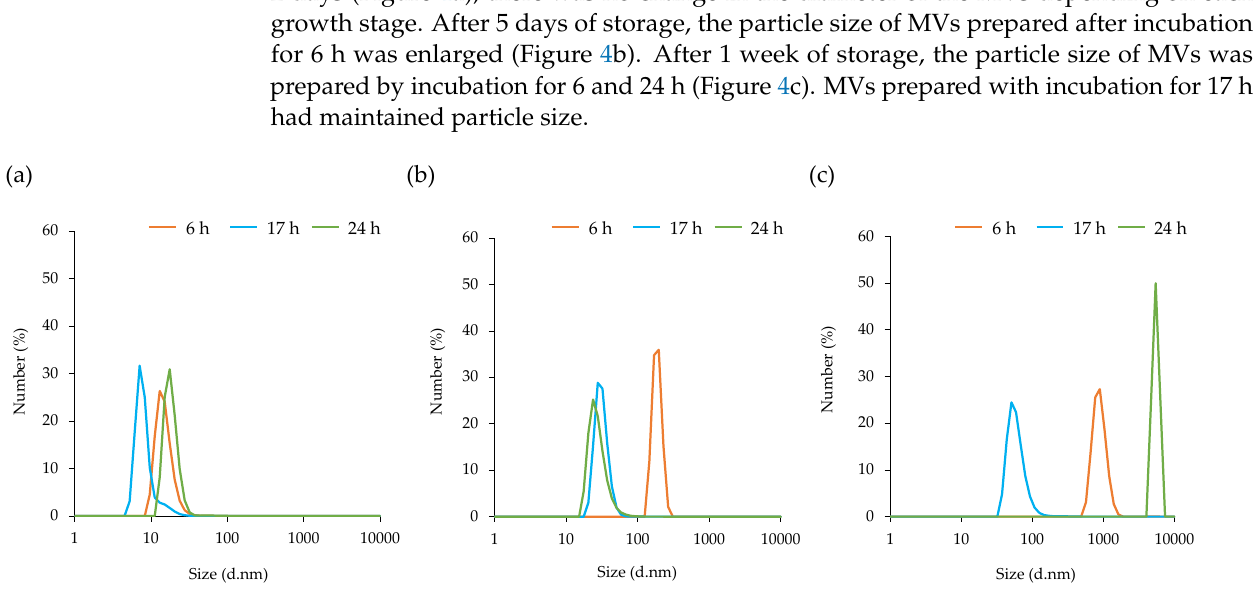
Figure 4. Stability of membrane vesicles (MVs) derived from Staphylococcus aureus . MVs prepared from the supernatant after culture for 6, 17, and 24 h were stored at 23 °C for ( a ) 2 days, ( b ) 5 days, and ( c ) 1 week. The average size distribution of the MVs was determined using dynamic light